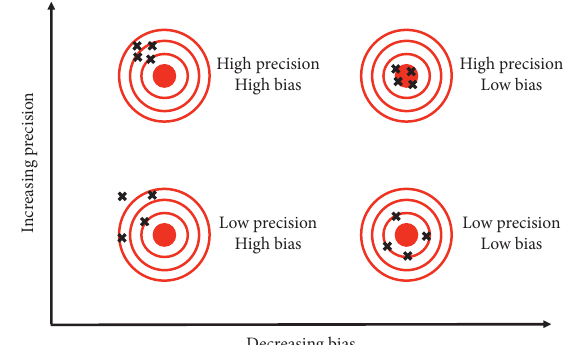
Figure 2: Precision and bias. Increasing precision reduces the random error and decreasing bias is equivalent to decreasing systematic error. The higher the precision and the lower the bias, the higher the internal validity of the study. Adapted from ELife, 7, e35718, Brandmaier, A. M. et al., Assessing reliability in neuroimaging research through intraclass effect decomposition (ICED) (2018) (modified)